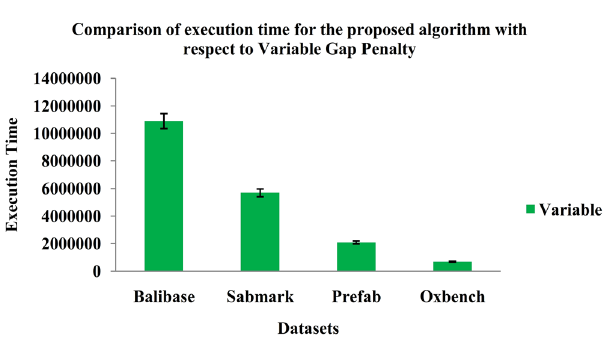
Figure 12. Execution time for the proposed BFO-GA algorithm with respect to Variable Gap Penalty.